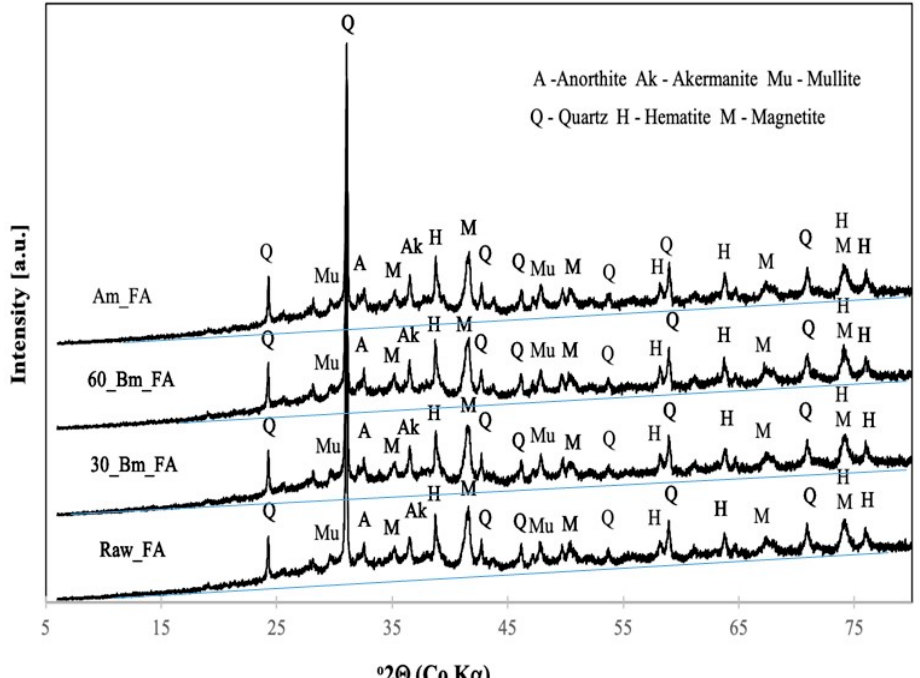
Figure 1. XRD patterns of the raw and milled fly ashes. Thin line shows the linear extrapolation from Figure 1. XRD pa tt erns of the raw and milled fl y ashes. Thin line shows the linear extrapolation data between 5 and 15 ◦ to 80 ◦ for the experimental baseline to provide a better visualization of the from data between 5 and 15° to 80° for the experimental baseline to provide a be tt er visualization of amorphous contribution with respect to the crystalline contribution given by the diffraction peaks.